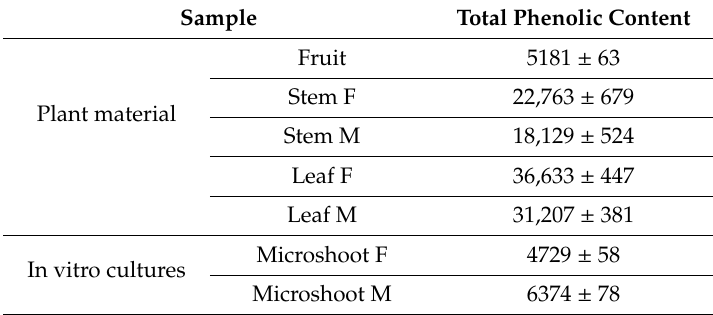
Table 6. Total phenolic content of plant material determined by Folin-Ciocaletu assay. Antioxidant